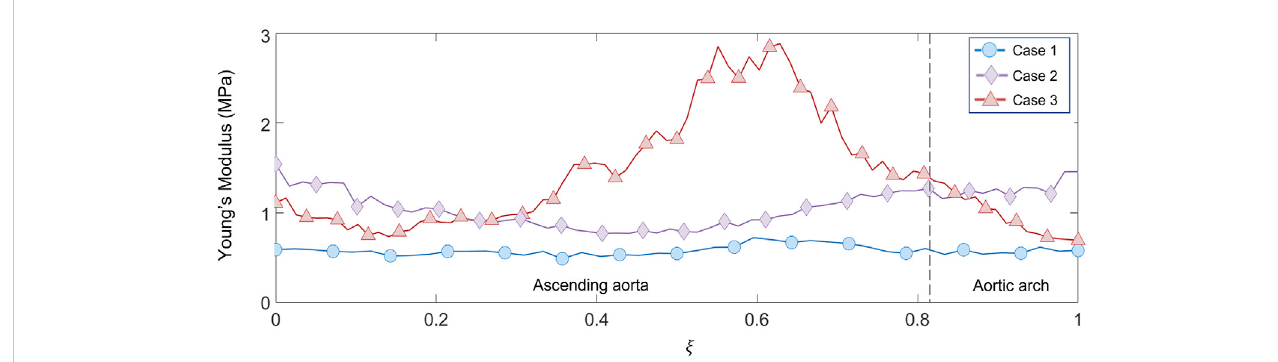
FIGURE 14 Young ’ s modulus variation along the centerline coordinate for the three patient-speci fi c